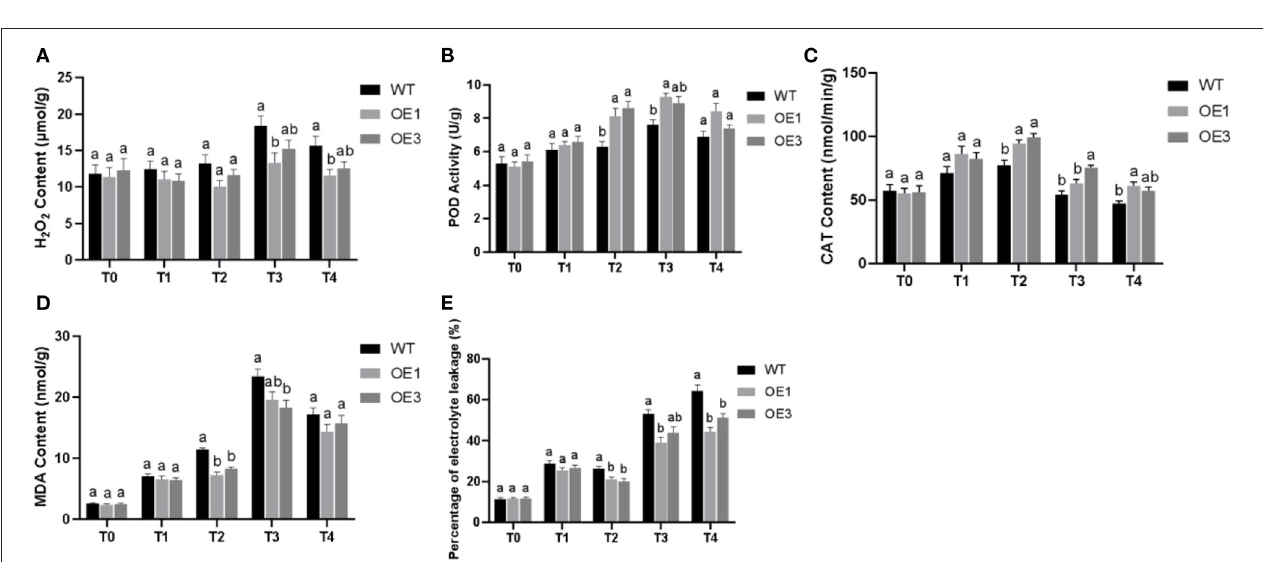
FIGURE 7 | The physiological characteristic analysis of wild type (WT) and PdPapWRKY28 -overexpression putative transformants treated with Fusarium oxysporum . Two transformants and WT were used as biological replicates for physiological analysis. (A) The result of hydrogen peroxide (H 2 O 2 ) content measurements; (B) The result of peroxidase (POD) activity measurements; (C) The result of catalase (CAT) activity measurements; (D) The result of malondialdehyde (MDA) contents; (E) The result of electrolyte leakage percentage. T0–T4: infection time was 0, 6, 12, 24, and 48h. Error bars represented the standard deviation of the three independent replicates. Significant differences ( P < 0.05) were indicated by different lowercase letters.